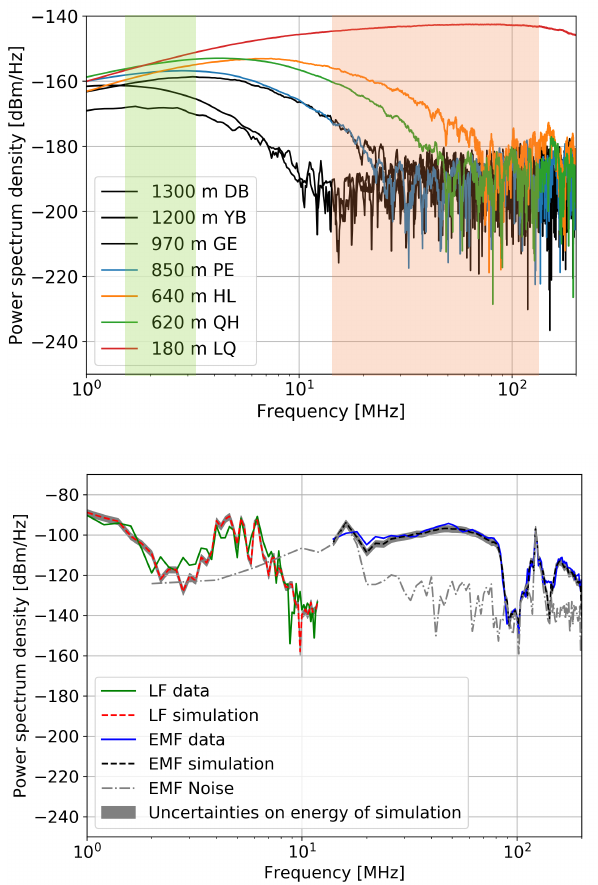
Figure 4: Left: simulated power spectrum density as a function of frequency calculated at the LF antenna loca- tions, in colour for the involved LF antennas and in black for the others. Distance to shower axis is also indicated. The colored rectangles give the limitations of the LF and EMF bands. Right: convoluted power spectrum density as a function of frequency for the LQ antenna, which detected the air